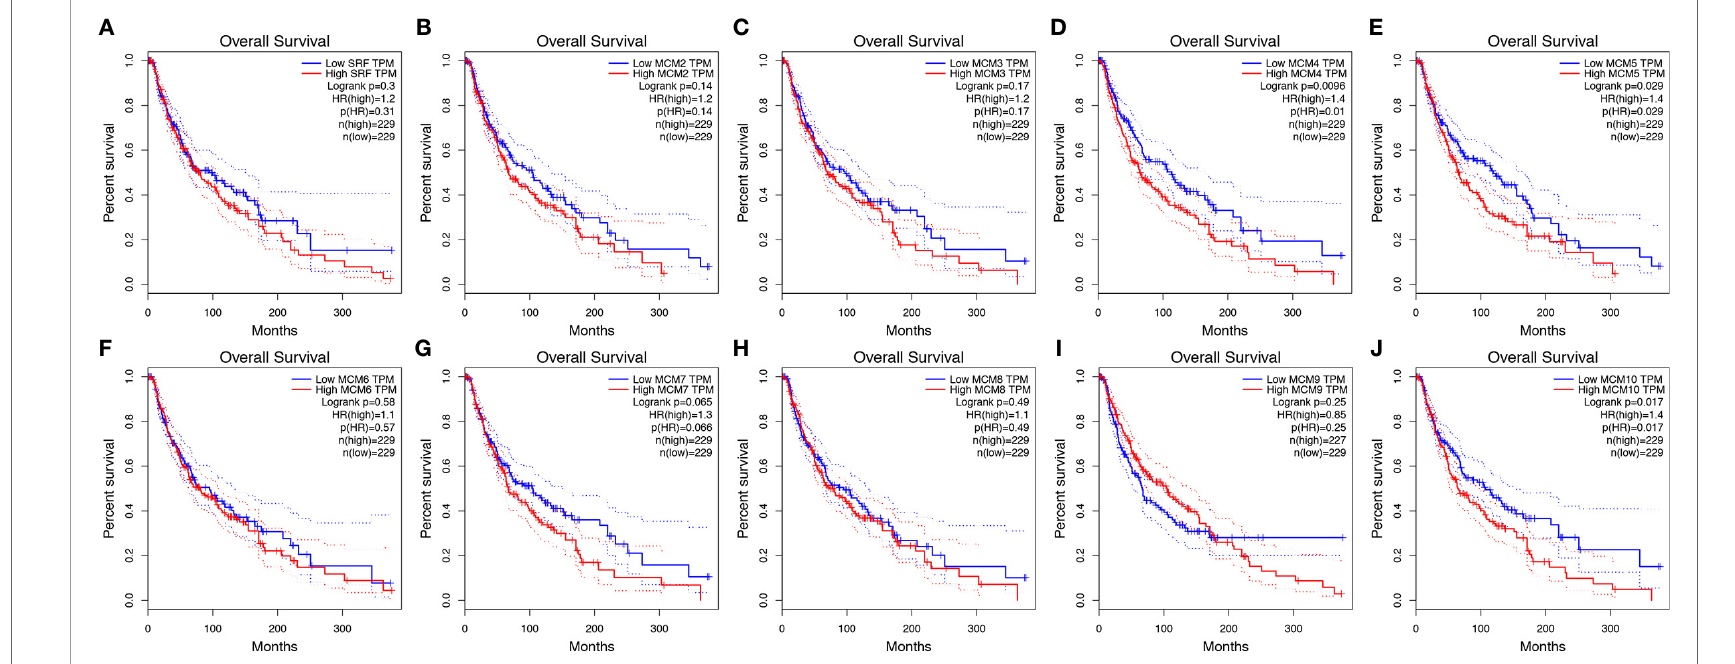
FIGURE 6 | (A – J) Kaplan-Meier survival analyses on differential MCM expression groups with OS in the TCGA SKCM patients. High expression of MCM4/5/10 were signi fi cantly correlated with poor